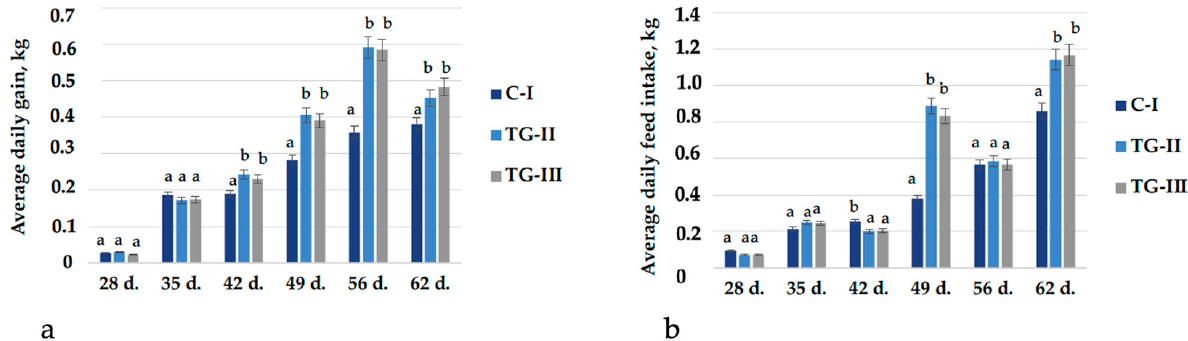
Figure 5. ( a ) The average daily gain (ADG, kg), ( b ) the average daily feed intake (ADFI, kg) ( a,b different letters indicate differences among treatments, p < 0.05; C-I—control group TG-II— treatment group with extruded–fermented wheat bran addition; TG-III—treatment group with sugar beet pulp; d.—day).